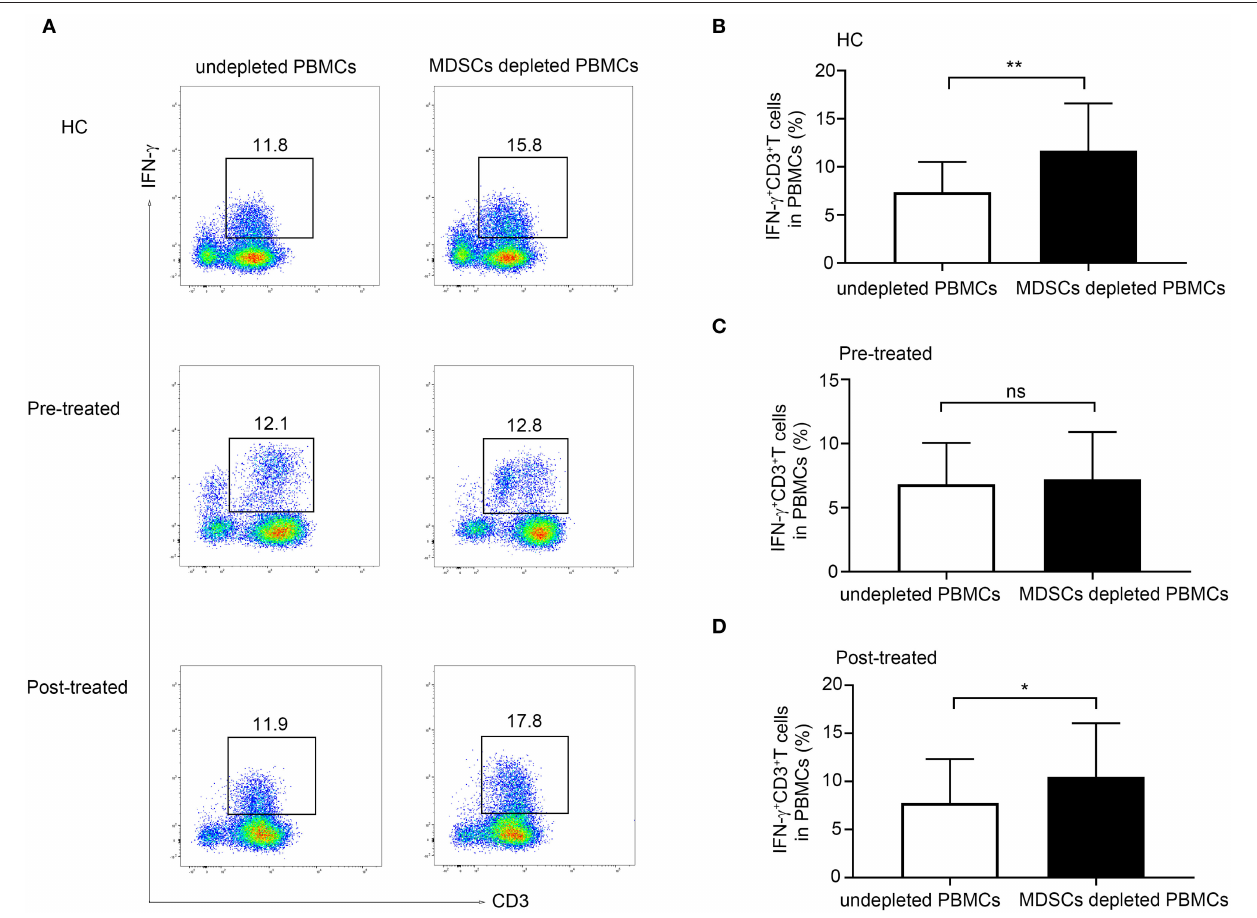
FIGURE 4 | Effect of MDSCs on IFN- γ production in CD3 + T-cell from HCs, patients with MG before and after immunotherapy. (A) Representative flow cytometry plots of IFN- γ + CD3 + T cells in MDSC depleted PBMCs compared with undepleted PBMCs from HCs, pre-treated, and post-treated patients. A significant increase in the frequency of CD3 + IFN- γ + T cells in MDSC depleted PBMCs compared with undepleted PBMCs from both HCs ( n = 5, B ) and from patients with MG after immunotherapy (n = 6, D ), but no significant change in untreated patients with MG ( n = 6, C ). Error bars represent mean ± SD. * p < 0.05, ** p <